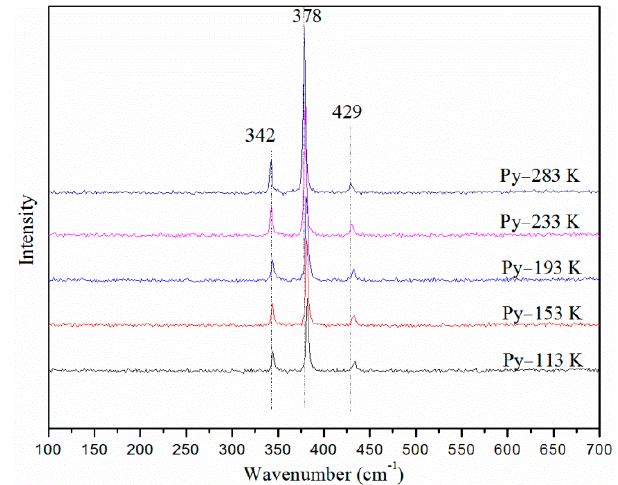
Figure 1. Raman shift of pyrite during cooling (113–283